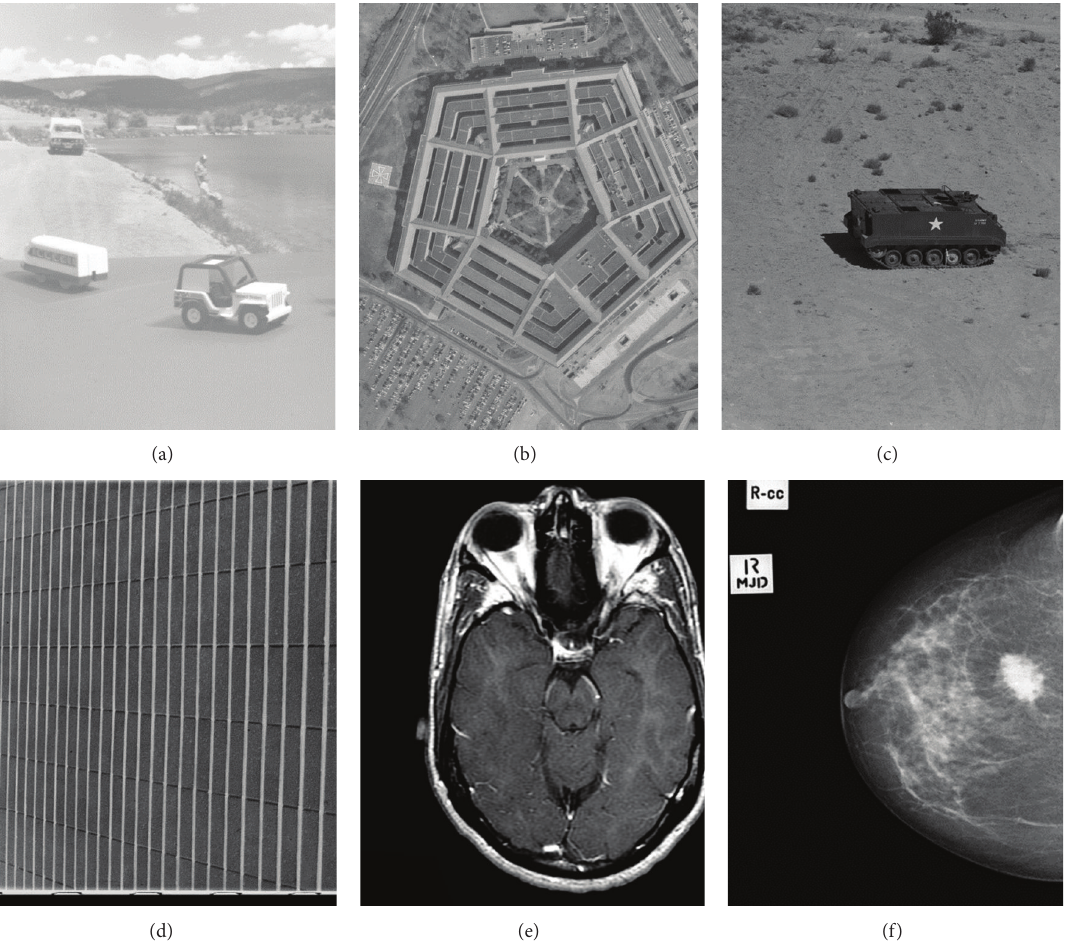
Figure 1: Examples of different image attributes. (a) Large uniform background, small targets, no randomness, and no peridic patterns; (b) semiperiodic, nonuniform background; (c) large uniform background, textured in upper part of image, nonperiodic; (d) periodic, nonuniform background; and ((e), (f)) random texture, nonpediodic, nonuniform